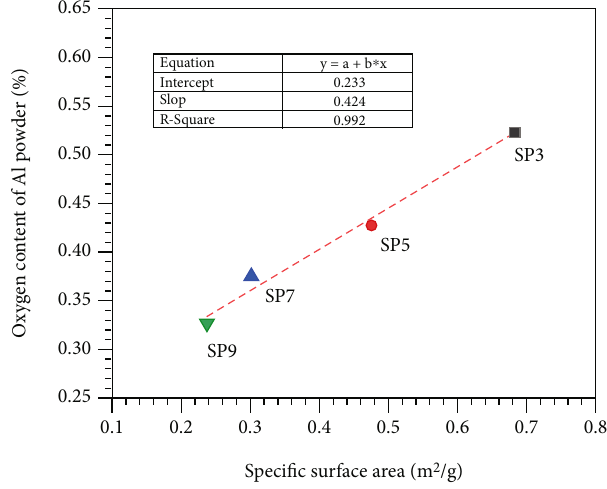
Figure 3: Relation between oxygen content and speci fi c surface area of Al powder with di ff erent particle sizes.